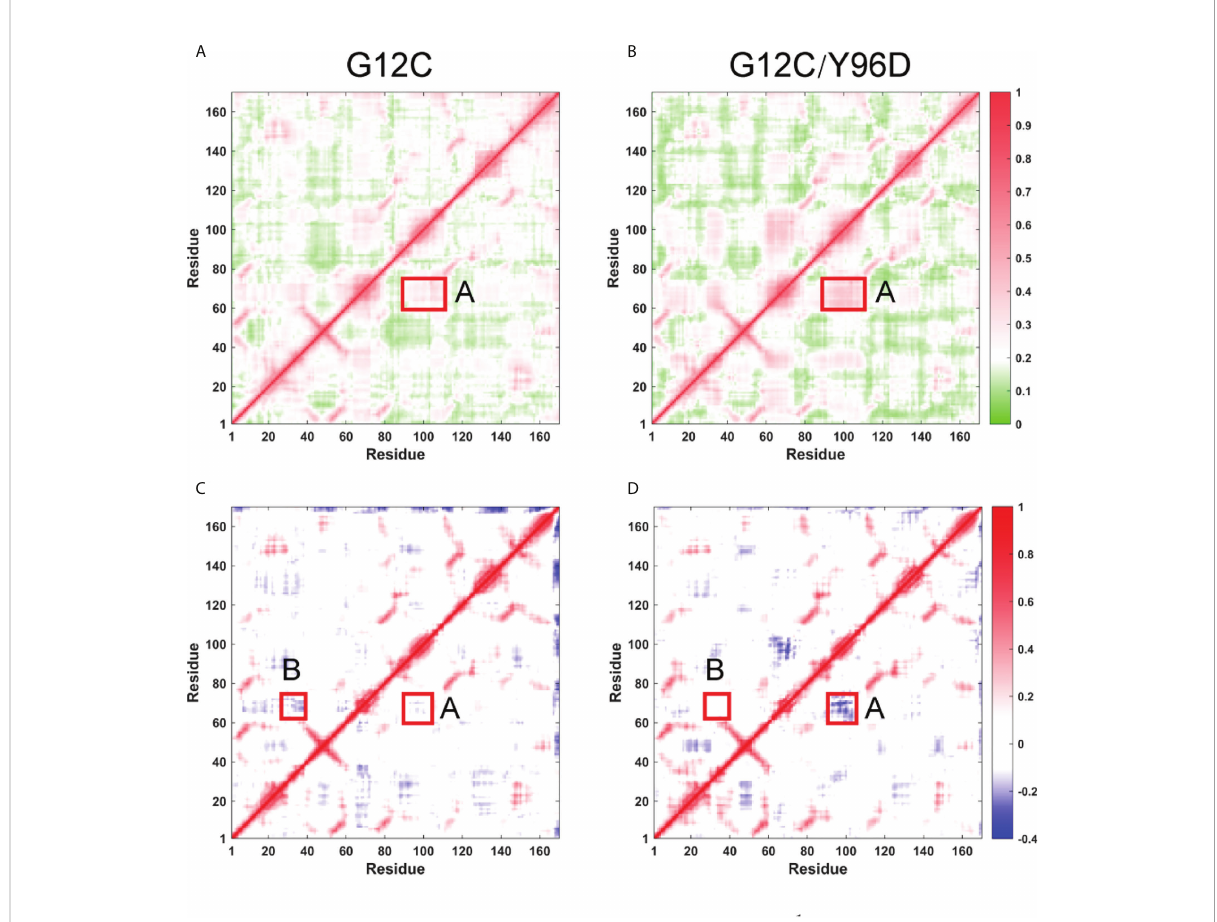
FIGURE 5 Inter-residue correlation of KRAS. Generallized residue correlation of the G12C system (A) and the G12C/Y96D system (B) . DCCM plot of the G12C system (C) and the G12C/Y96D system (D) . The signi fi cant correlation differences are highlighted with a rectangle in each panel. Regoin A represents the correlation between switch II and a 3-helix while regoin B represents the correlation between switch I and switch